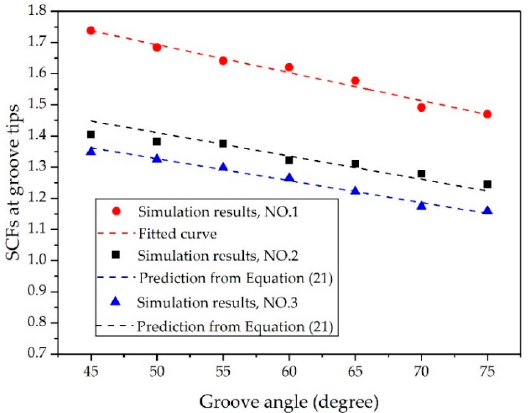
Figure 8. Relationship between groove angle θ and SCFs at groove tips.